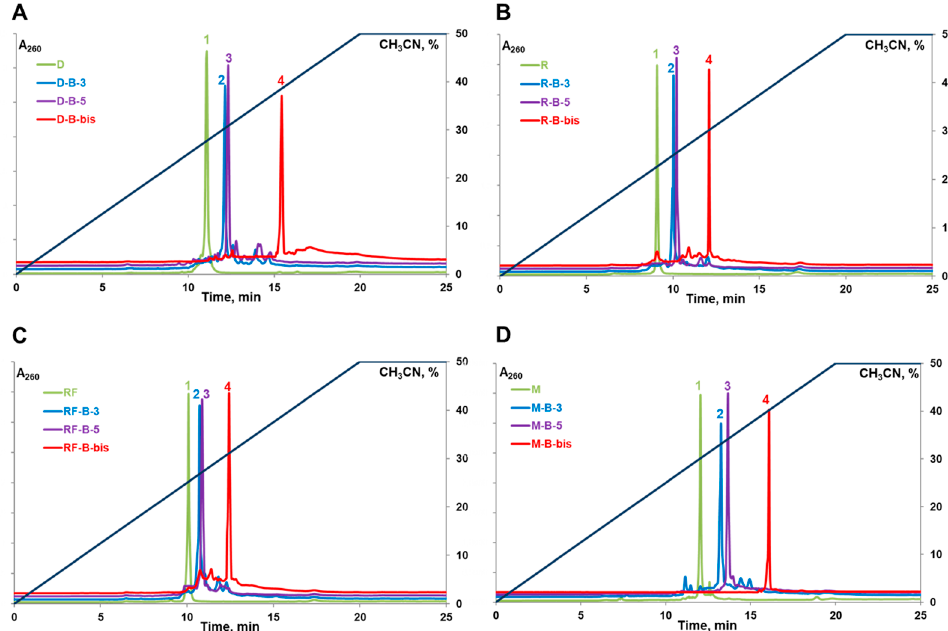
Figure 3. Reversed-phase high-performance liquid chromatography (RP-HPLC) analyses of parent oligonucleotides (profile 1) and their 3 ′ -conjugates (profile 2), 5 ′ -conjugates (profile 3), and dual 3 ′ ,5 ′ -conjugates (profile 4) with closo -dodecaborate. ( A )—oligodeoxyribonucleotide D and its conjugates; ( B )—oligoribonucleotide R and its conjugates; ( C )—2 ′ -F-Py RNA oligomer RF and its conjugates; ( D )—oligo(2 ′ -O-methylribonucleotide) M and its conjugates. See Materials and Methods for the RP-HPLC conditions.